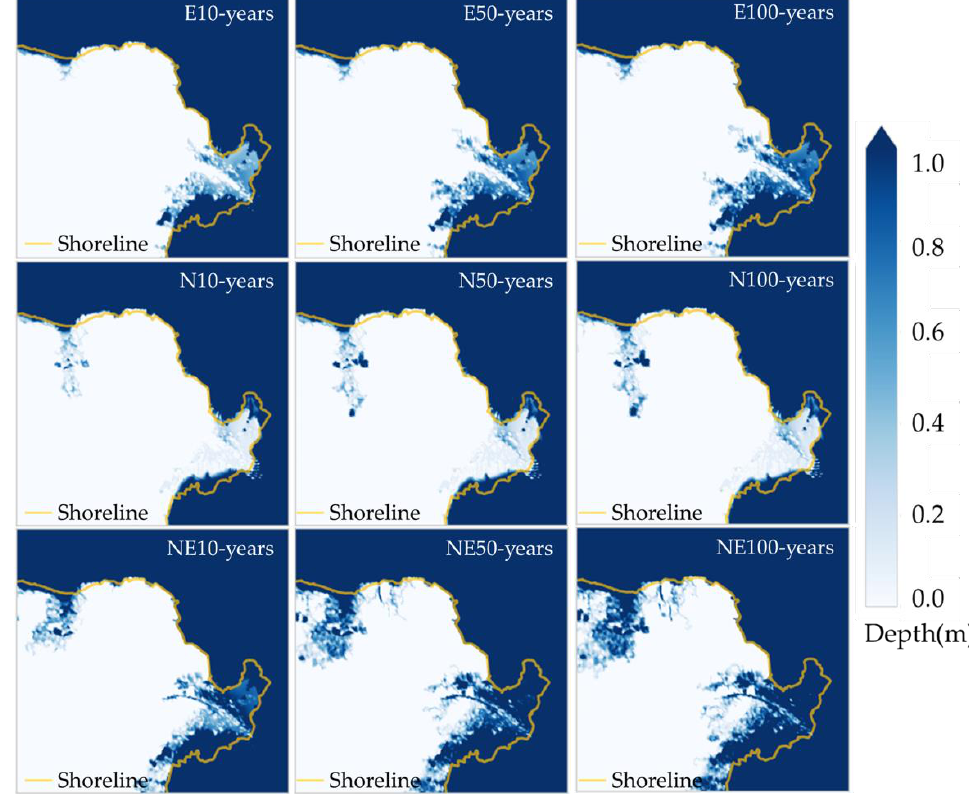
Figure 9. Inundation area in the 36th hour of different return periods winds.